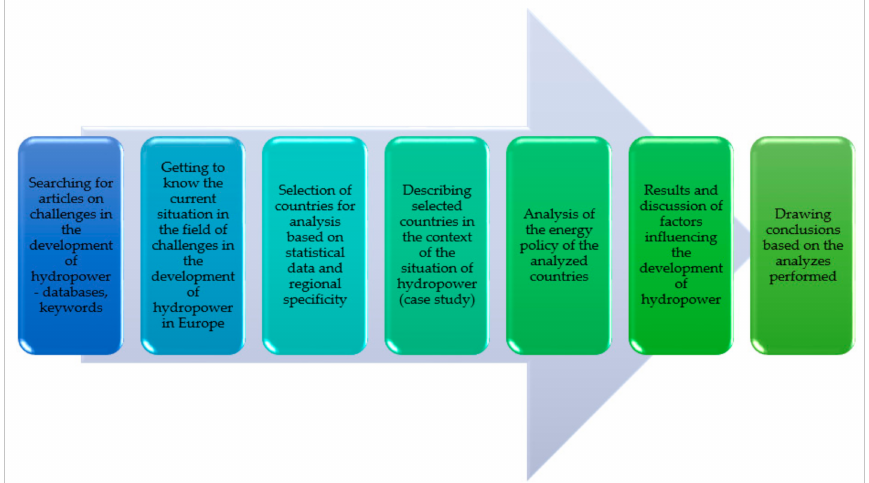
Figure 4. The course of the article writing